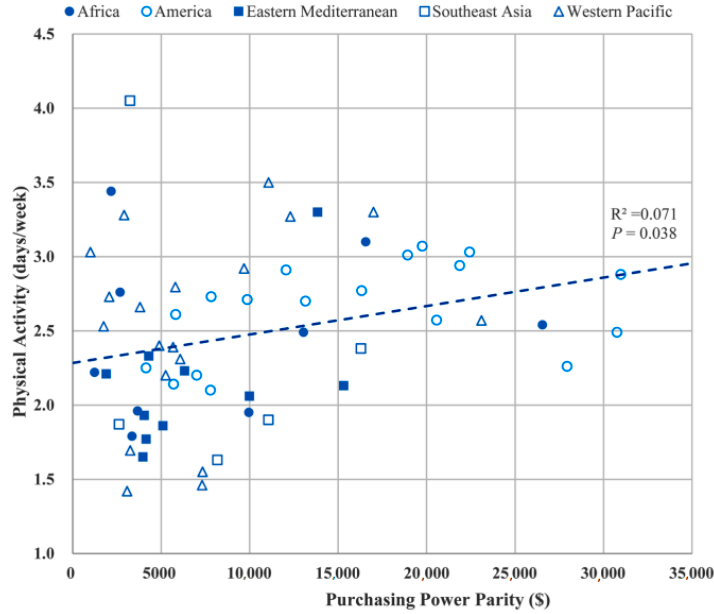
Figure 1. Mean daily duration of physical activity of any kind by purchasing power parity per capita in 68 LMICs and 5 WHO regions. Int. J. Environ. Res. Public Health 2020 , 17 , x